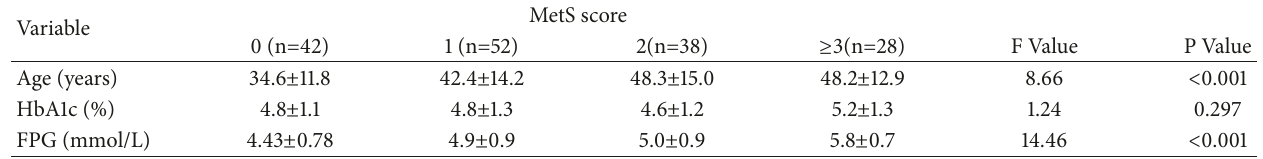
Table 3: Biochemical characteristics stratified by MetS component score.